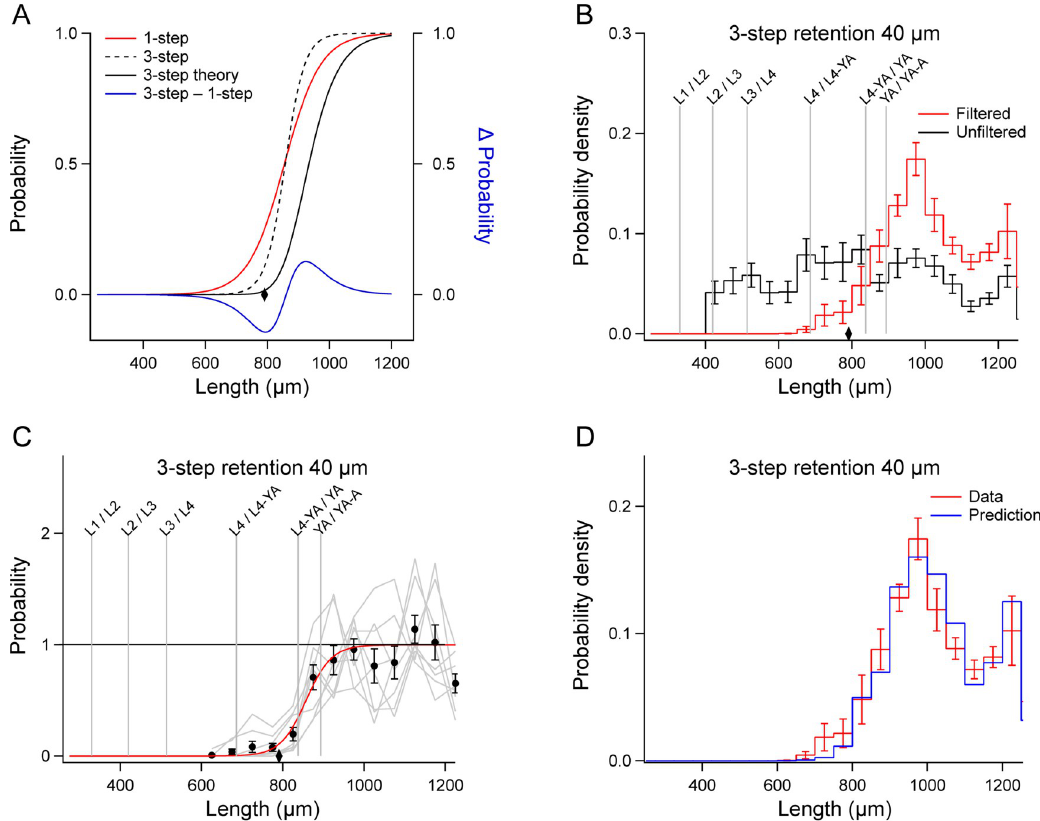
Fig 6. Non-ideal properties of 3-step filtration. A. Comparison of theoretical and actual filter functions. The red trace is 1-step retention, 40 μ m filter function from Fig 4B. The black trace is the 1-step filter function raised to the third power. The dashed black trace is the actual three-step filter function obtained by the analysis of the data in B, shown in C. The blue trace is the difference ð l Þ ( red trace ), and unfiltered distributions, H ð l Þ ( black between the 1-step and 3-step filter functions. B. Filtered distributions, H f u trace ). The diamond indicates the length of worms having a diameter equal to the mesh size. Error bars, SEM. C. Filter function for 3-step filtration. Gray traces show the value of the ratio on the right-hand side of Eqs 2 and 3 for each run, after multiplication by the constant C (see text) so that the mean of data points in the asymptotic region is 1. Black symbols indicate means of gray traces at each length. Error bars, SEM. The red trace is the fit of Eq 4 to the mean data. Number of extreme data points in the asymptotic region used to compute C is given in S1 Table. D. Validation of the 3-step filter function. The unfiltered length distribution H ð l Þ in B was multiplied by the filter function in C, yielding the blue trace (Prediction). The r ed trace (Data) shows u the actual filtered distribution H ð l Þ in f